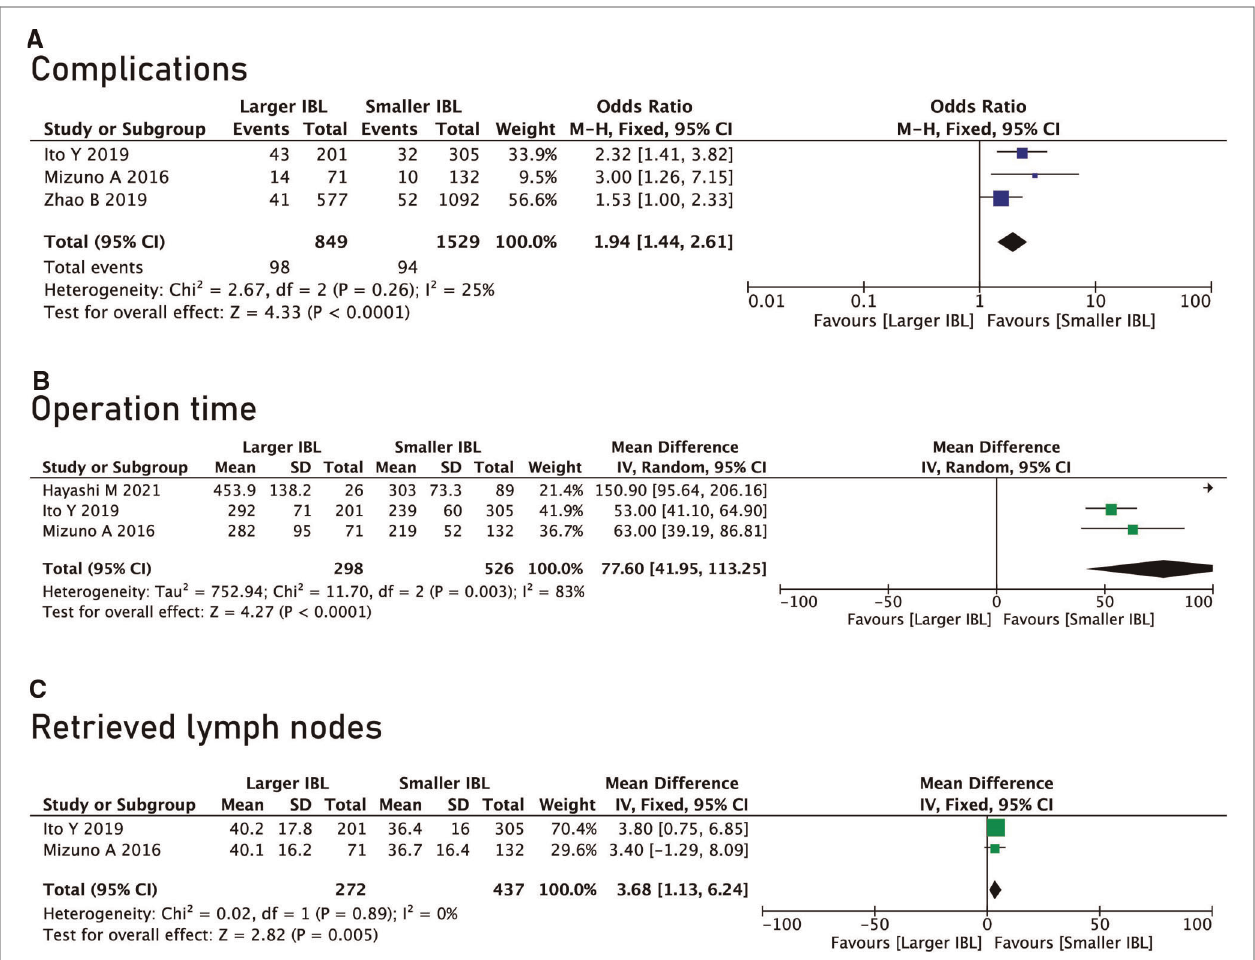
FIGURE 2 | Surgical information and postoperative complications. ( A ) Complications; ( B ), Operation time; ( C ), Retrieved lymph